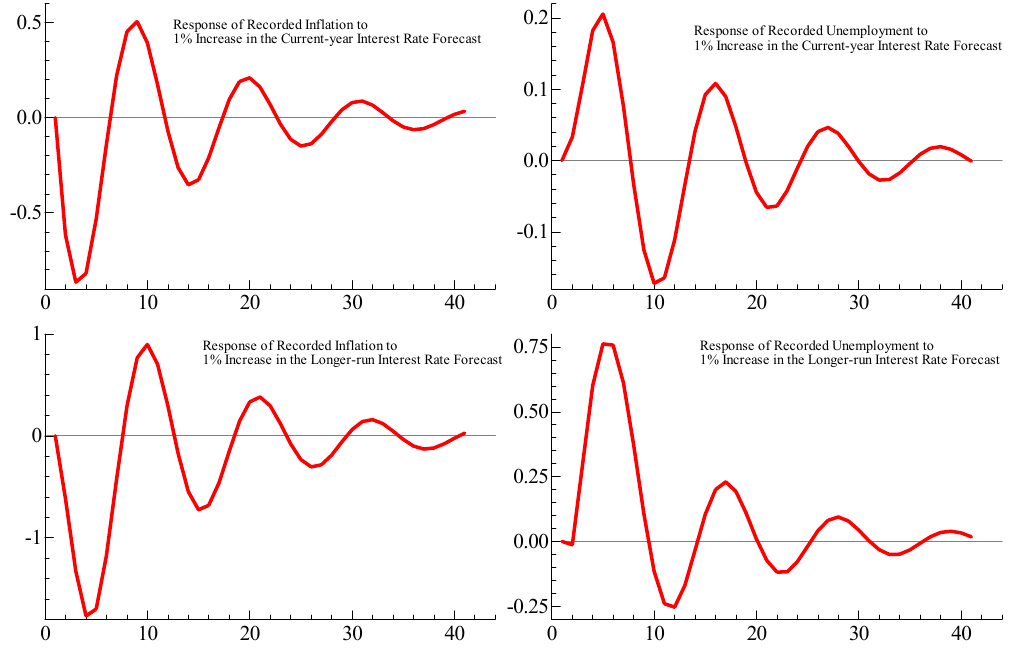
Figure A6. Response of Recorded Inflation and Unemployment rates to changes in the current-year and longer-run forecasts of interest rates.